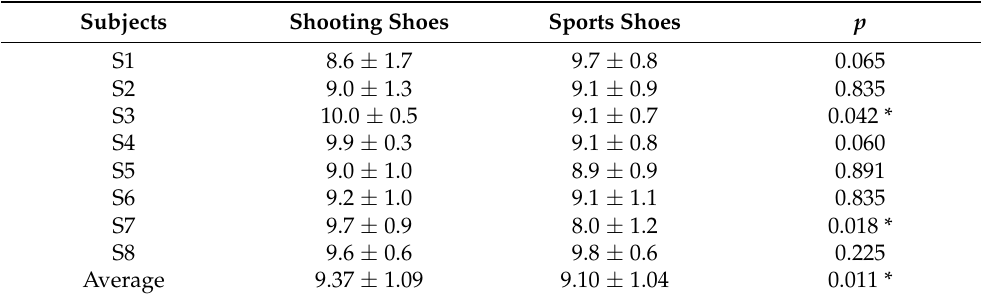
Table 3. Shooting scores for participants wearing shooting shoes and sports shoes (MEAN ± SD)